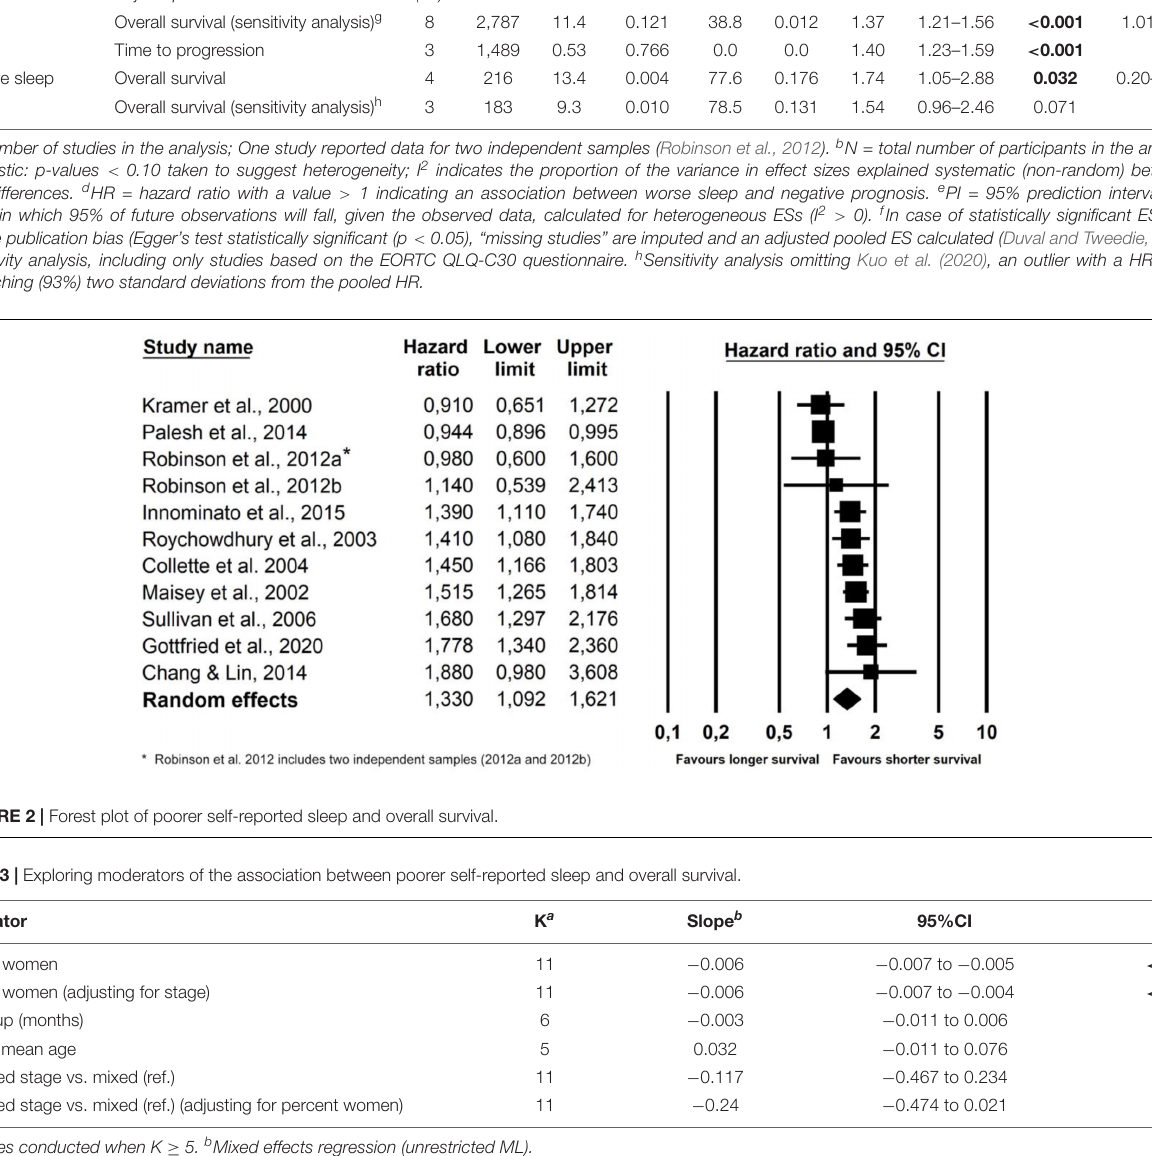
Heterogeneity c Pooled results